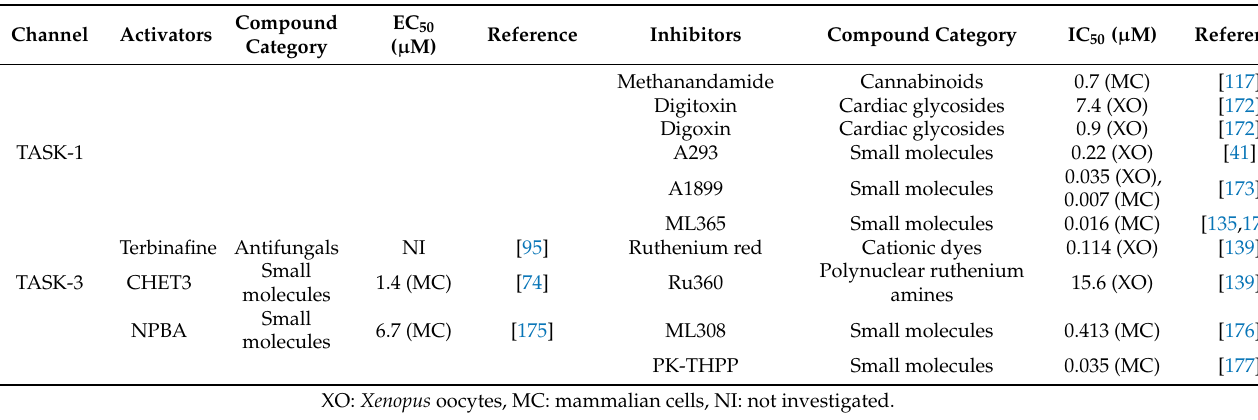
Table 2. List of selectively targeted compounds.